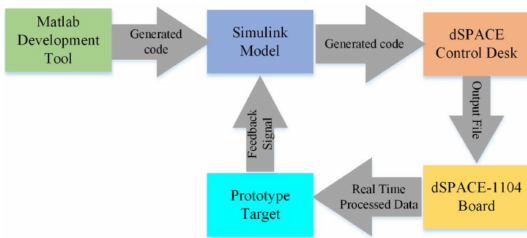
Figure 7. Integration of MATLAB-dSPACE Code Generation block